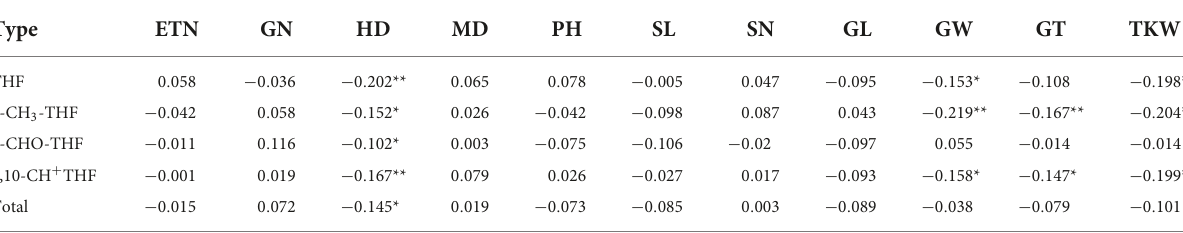
TABLE 3 Correlation of folate contents and important agronomic